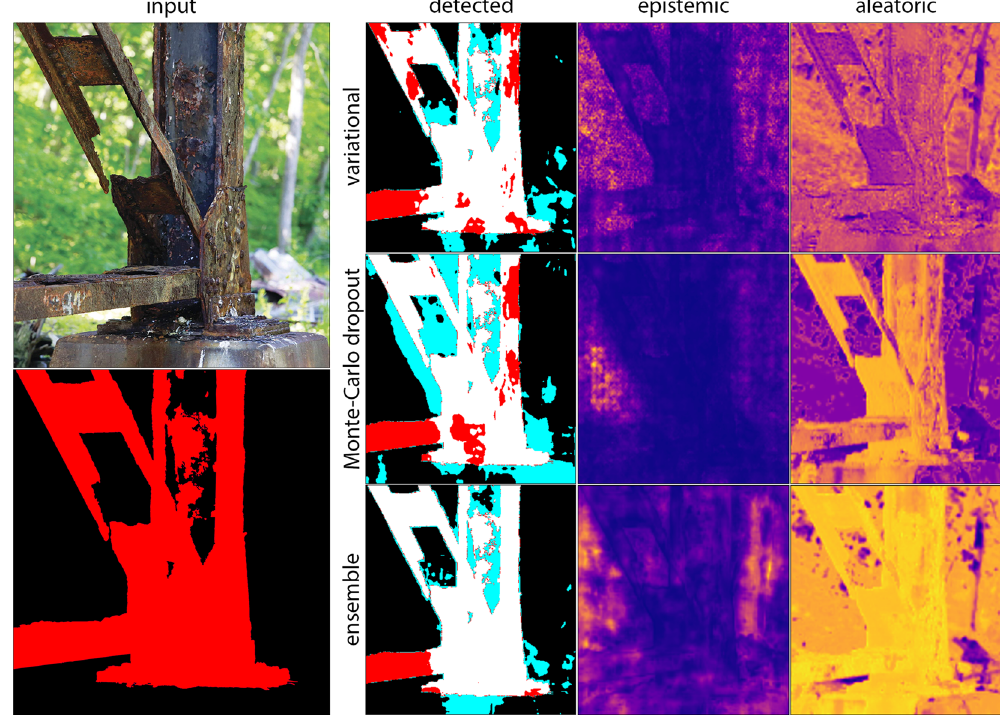
Fig. 12 Bridge column image and model outputs. Example from Out of Distribution set: Left panel: input image and ground truth label map; Right panel: top row: variational model outputs, middle row: Monte-Carlo dropout model outputs; bottom row: ensemble model outputs; left column: detection maps; middle column: epistemic uncertainty; right column: aleatoric